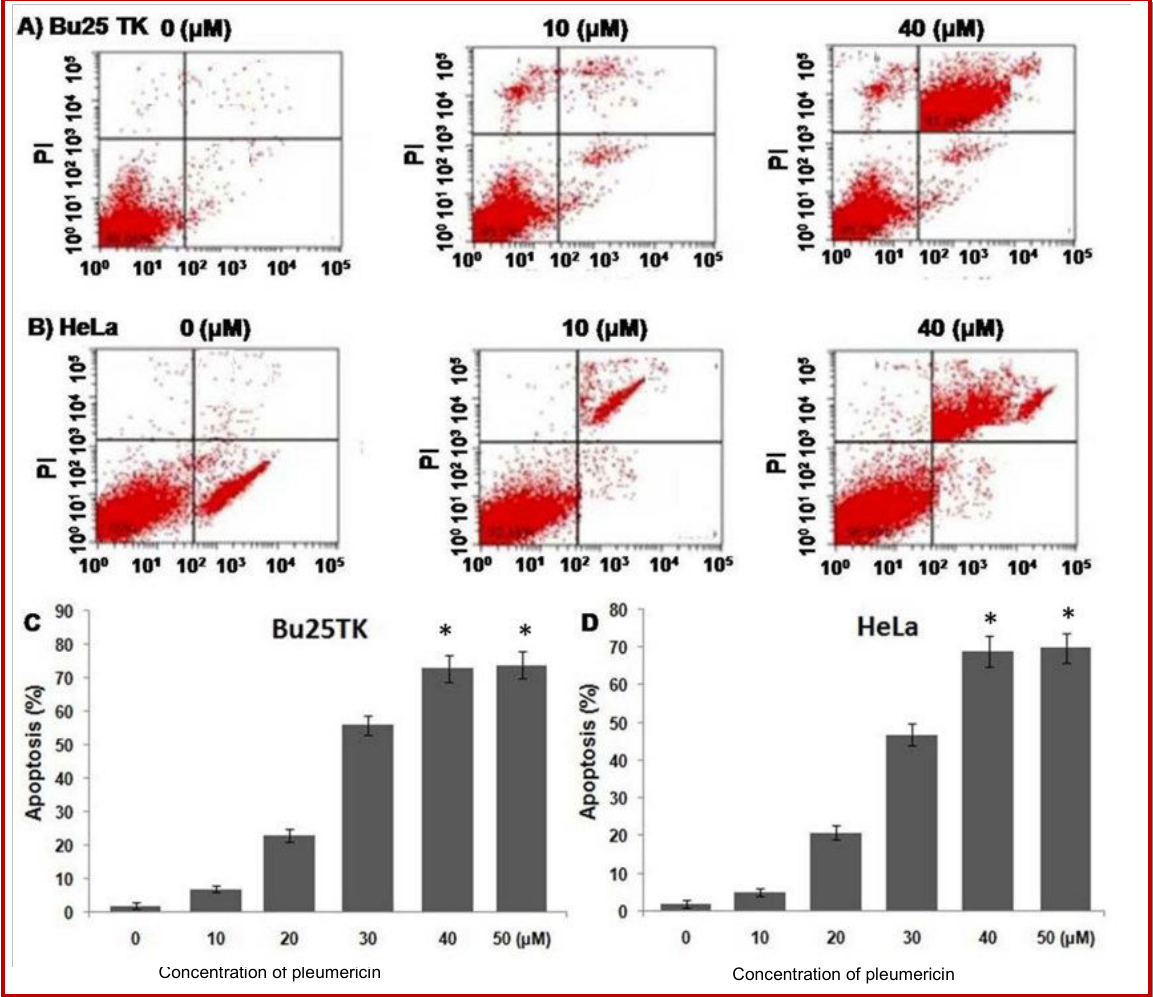
Figure 3: Induction of apoptosis in Bu25TK and HeLa carcinoma cells by plumericin. (A) Analysis of apoptosis in Bu25TK and HeLa by annexin-V and PI staining. (B, C) Proportion of apoptotic cells following 48 hours of incubation with plumericin. The data presented are the mean ± S.E. of the three experiments performed independently. *p<0.05, compared with the